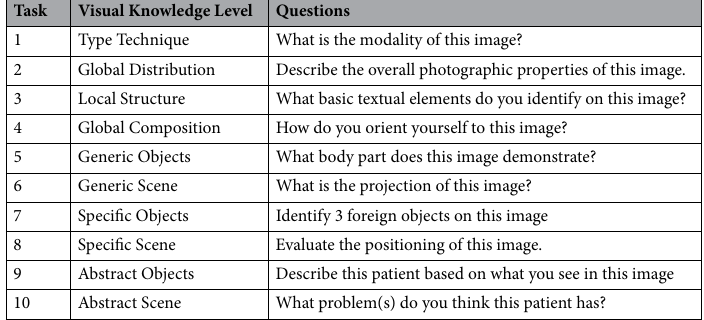
Table 1. 10-Level knowledge structure with corresponding experiment